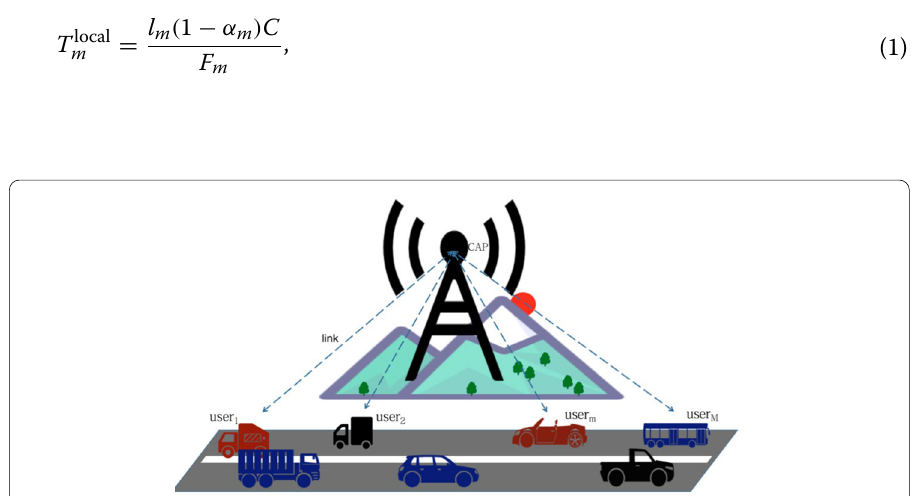
Fig. 1 System model of the considered vehicular